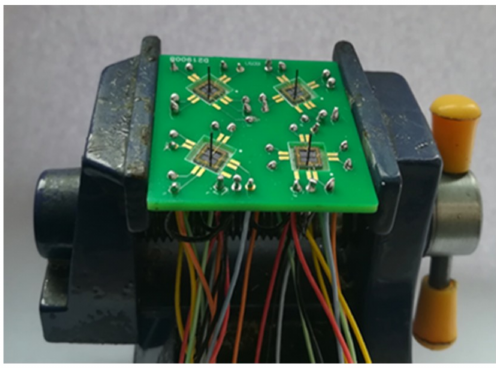
Figure 10. The fabricated array MEMS vector